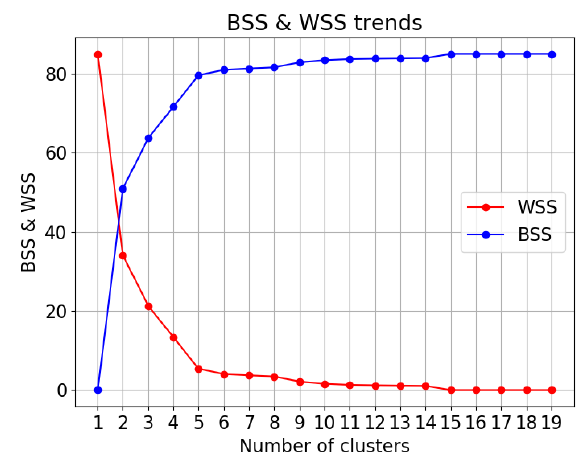
Figure 2. WSS and BSS trends